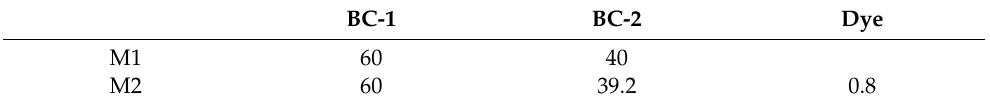
Table 1. M1 and M2 mixture fractions